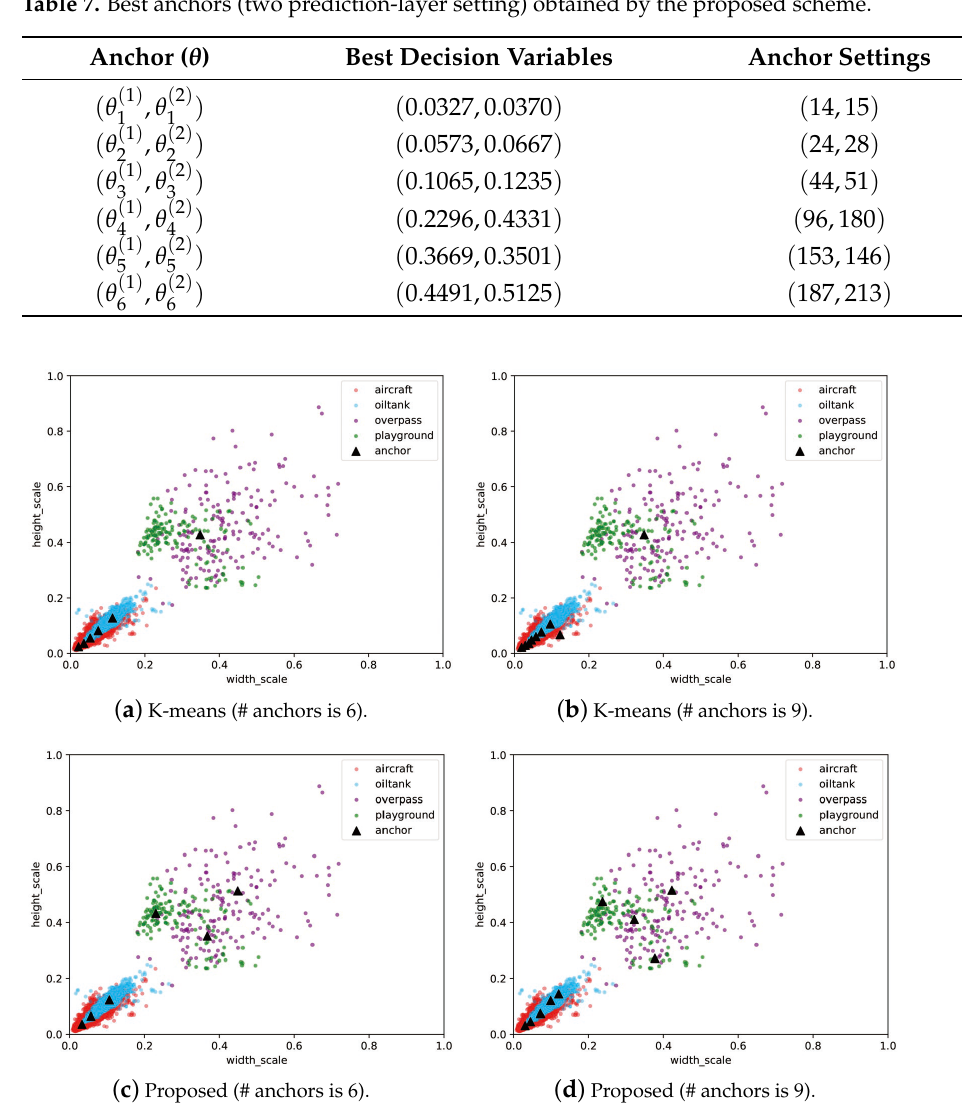
Figure 7. Distributions of the ground truth bounding boxes and the anchors obtained by using K-means clustering and the proposed scheme on the RSOD